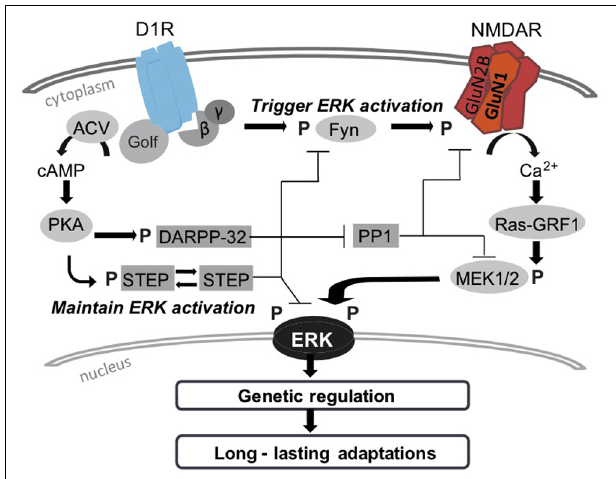
FIGURE 1 | Cocaine, similarly to most drugs of abuse, produces long lasting brain changes, that relie on gene expression and new protein synthesis. These long-term neuronal adaptations take place in majority in DA-D1R expressing MSNs that belong to the direct pathway.The ERK pathway is central in this striatal plasticity, and detects a combination of glutamate and DA signals that are essential for long lasting modifications. Cocaine-induced ERK activation depends on complex cascade of phosphorylation events downstream D1-R. Importantly, the triggering event in ERK activation depends on a non-canonical signaling pathway that associates Fyn-induced phosphorylation of GluN2B and increases in calcium influx into D1-R MSNs.The duration and maintenance of ERK activation occurs via cAMP/PKA pathway.The cAMP/PKA pathway, downstream D1 receptors (left panel) triggers deactivation of phosphatases, PP1 on one hand via DARPP-32, and STEP on the other hand (Valjent etal., 2005). By controling the activity of the tyrosine kinase Fyn and the dual specificity protein kinase MEK, this signaling cascade intervenes in the state of phosphorylation of ERK downstream DA-D1R stimulation. However, we propose that triggering ERK activation depends on a “non-canonical signaling” pathway downstream D1-R (right panel). A cAMP-independent activation of Fyn produces tyrosine phosphorylation of GluB2B subunit of NMDA-Rs that in turn facilitates calcium influx (Pascoli etal., 2011a), and activation of the calcium-sensitive Ras-guanine releasing factor (Ras-GRF1) that activates the MEK/ERK pathway (Fasano and Brambilla, 2011). Upon cocaine stimulation ERK translocates to the nucleus where it controls epigenetic and genetic programs. Among the latter, the transcription factor Elk-1 is a component of the ternary complex factor, which binds to SRE (Besnard etal., 2011a). ERK1/2 also phosphorylates the nuclear kinase MSK1which appears to play a prominent role in phosphorylation of histone H3 and cAMP-response element-binding (CREB) protein (Brami-Cherrier etal., 2005).This leads to the expression of immediate-early genes, which are particularly sensitive to CREB (e.g., cFos) or ternary complex factor (e.g., Zif268 a.k.a. Egr-1).These two nuclear pathways downstream from ERK have distinct roles in long-term behavioral adaptations (see text). DA-GPCR and NMDAR, in particular D1R and GluN1, oligomerization has been documented in heterologous systems, hippocampal, and striatal tissues after cocaine exposure.The role of D1R-GluN1 interaction in ERK activation and downstream molecular events remains to be